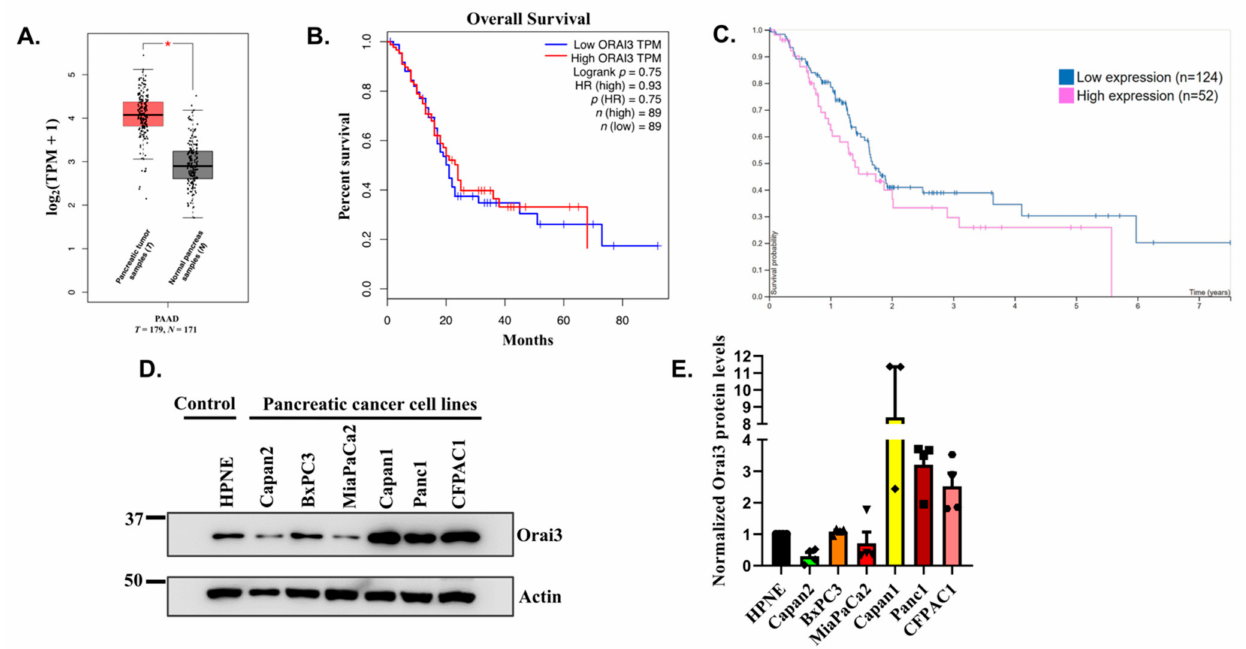
Figure 1. Orai3 expression is inversely associated with the mean survival time of pancreatic cancer patients. ( A ) Orai3 expression analysis in GEPIA (Gene Expression Profiling Interactive Analysis) database having 179 pancreatic tumor samples ( T ) and 171 normal pancreas samples ( N ). Here “*” indicates that Orai3 expression is significantly higher in pancreatic tumor samples in comparison to normal pancreas samples. ( B ) Pancreatic cancer patients’ survival analysis in GEPIA wherein blue trace corresponds to low Orai3 expression ( n = 89 patients) and red trace represents high Orai3 expression ( n = 89 patients) clearly suggesting that higher Orai3 expression is associated with less patient survival time. ( C ) Pancreatic cancer patients’ survival analysis in “The Human Protein Atlas” database where blue trace corresponds to low Orai3 expression ( n = 124 patients) and red trace represents high Orai3 expression ( n = 52 patients) demonstrates that higher Orai3 levels are associated with poor prognosis and leads to decrease in patients’ survival time. ( D ) Western blot analysis for examining Orai3 protein levels in well-established pancreatic cancer cell lines and transformed “normal” pancreatic cells. ( E ) ImageJ based densitometric analysis of Orai3 expression in pancreatic cancer cell lines suggest differential Orai3 expression profile ( n =